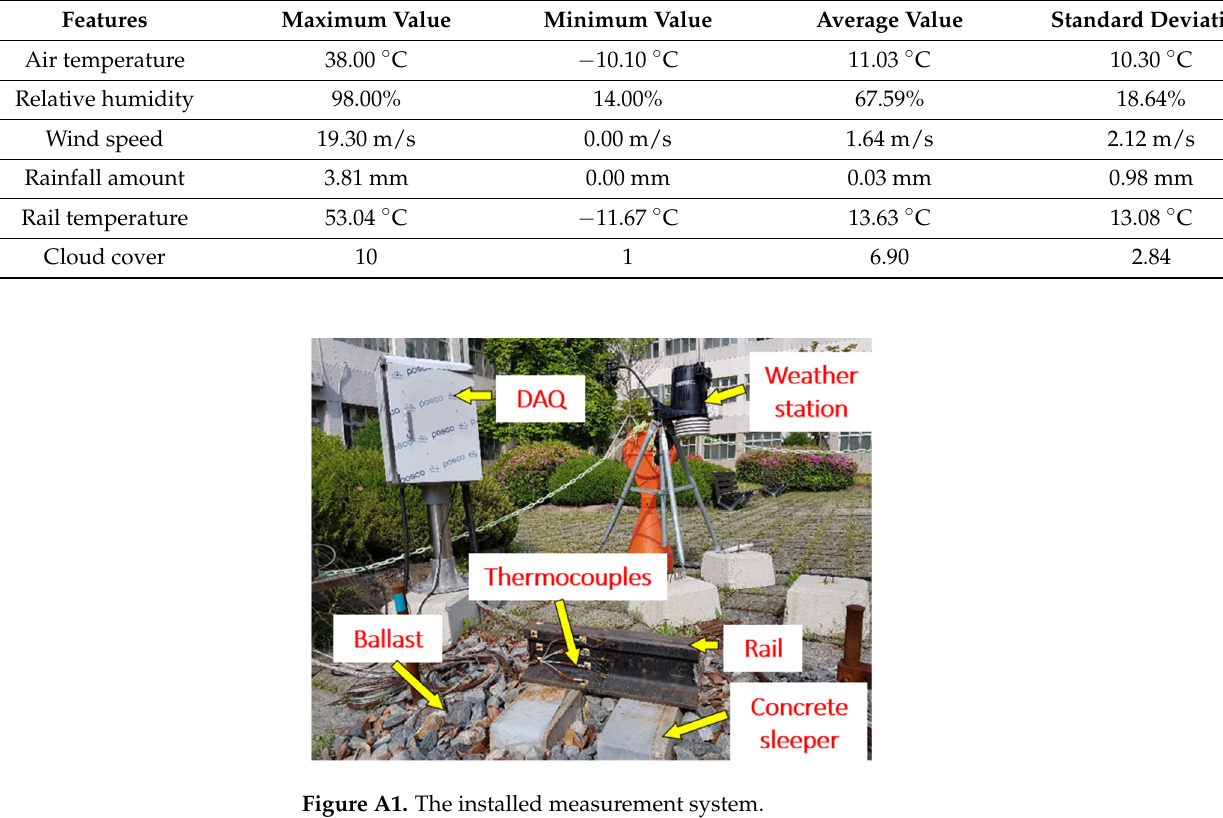
Table A1. Summary of the dataset (from August of 2016 to May of 2017).